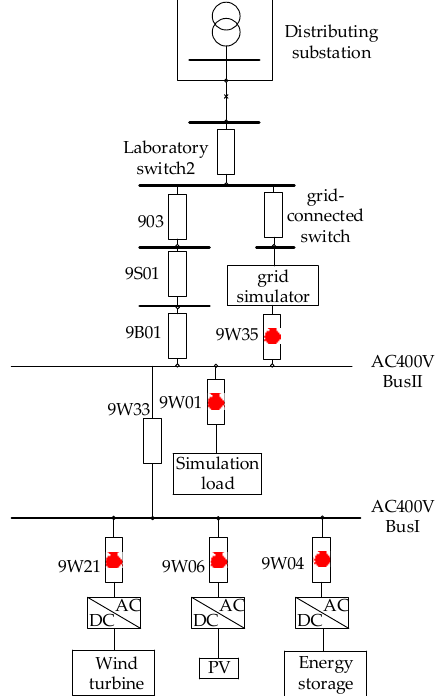
Figure 9. Electrical wiring diagram of modeling simulation and test of the microgrid.